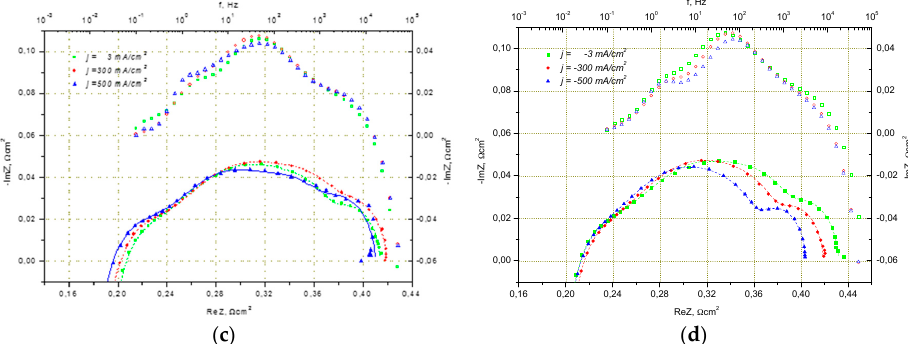
Figure 4. Impedance spectra of electrolyte supported cell (ESC) with LSMM’/10Sc1CeSZ and Ni/YSZ electrodes at 800 °C in the fuel cell ( a ) and electrolysis; ( b ) modes (air, H 2 /H 2 O = 50/50) at different current densities and impedance spectra of the ESC with LSMM’/ScSZ and Ni/GDC electrodes at 800 °C in the fuel cell; ( c ) and electrolysis; ( d ) modes (air, H 2 O/H 2 O = 50/50) at different current densities.